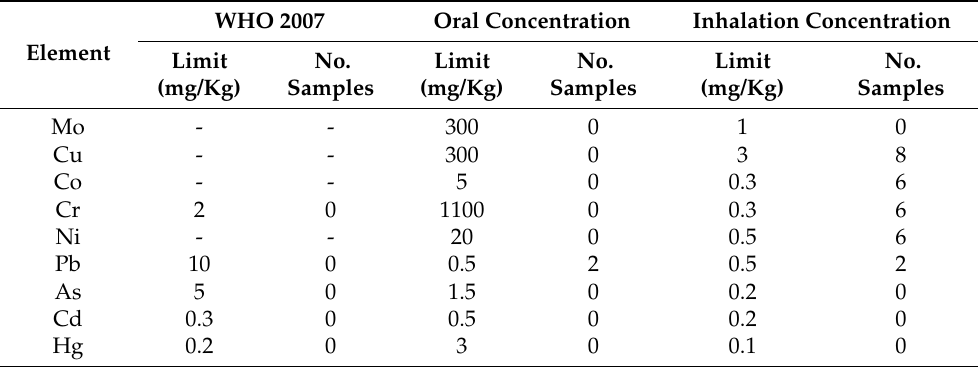
Table 3. Number of Italian hemps exceeding the World Health Organization (WHO) and US Phar- macopeia (USP) limits in terms of inorganic elements. WHO limits refer to the maximum content of elements allowable in raw herbal materials intended for medicinal use. USP sets the threshold of elements for both oral intake and inhalation of cannabis products, considering the consumption of 10